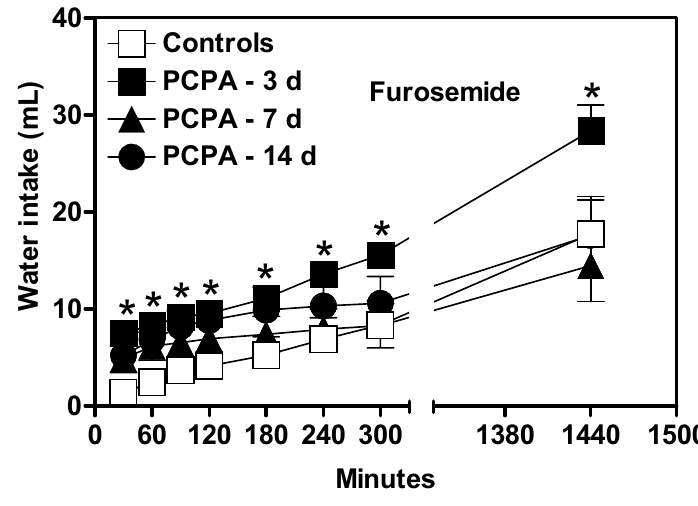
Fig. 3 – Chronic effect of treatment with p-chlorophenylalanine (PCPA, 300 mg/kg, ip , for 2 days), 3, 7 and 14 days after the first injection, on the dipsogenic response induced by sodium depletion mediated by furosemide (20 mg/kg, sc , 24 h before beginning of experiment). Mean values represent cumulative water intake from 30 min up to 24 h. Data are reported as means ± SE. ∗ P < 0 . 05 compared to controls.